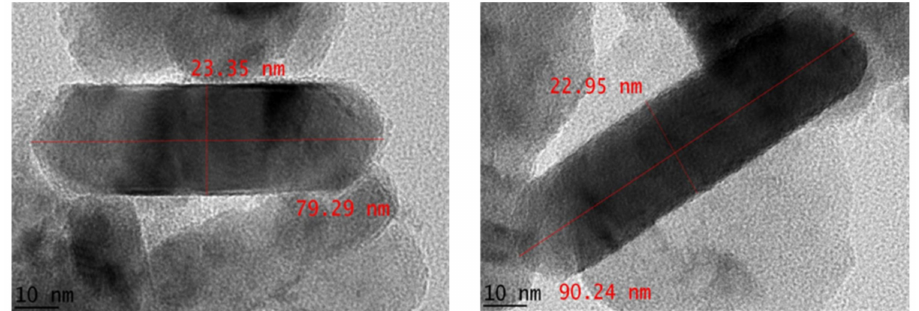
Figure 7. TEM images of M. calabura derived CuO